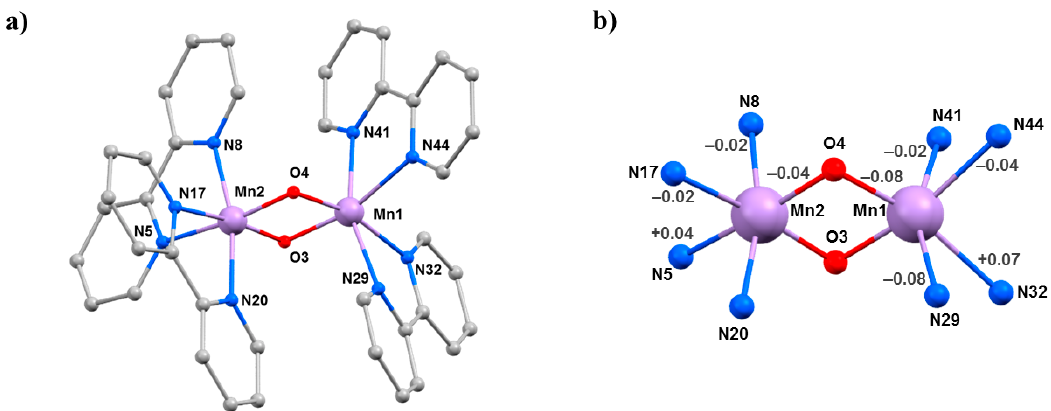
Figure 8. ( a ) The molecular structure common to complexes 5 · 3MeCN and 6 · 2MeCN · H 2 O. ( b ) Variations in the bond lengths from ambient pressure to 2.00 GPa in 5 · 3MeCN. Only statistically significant changes are shown. Colour code: Mn = lilac, O = red, N = blue, C = grey. H atoms, counterions and solvent molecules are omitted for clarity.